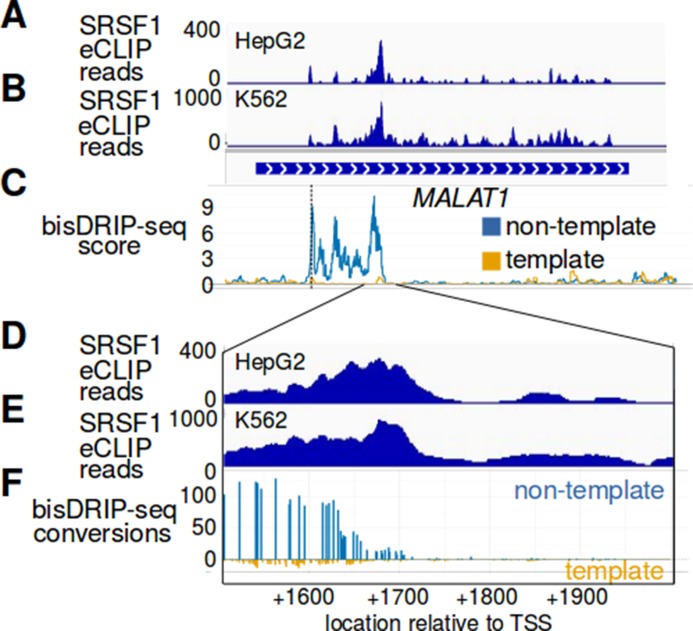
The R-loop in MALAT1 ends at an SRSF1 binding site.(A–F) SRSF1 preferentially binds MALAT1 RNA near the location corresponding to the end of the MALAT1 R-loop. SRSF1 is a splicing factor that was previously shown to suppress R-loop formation (Li and Manley, 2005). SRSF1 eCLIP reads were mapped to the MALAT1 genome locus from the (A) HepG2 ENCFF327NVE ENCODE dataset and from the (B) K562 ENCFF137IAG ENCODE dataset. The cell type is indicated at the top left of each plot. Below the SRSF1 eCLIP reads is a gene model of the MALAT1 genomic locus. (C) The mean bisDRIP-seq scores for the non-template strand (blue) and template strand (orange) of control-treated samples (n = 13) were mapped to the same MALAT1 genomic locus. In (D–F), the region near the end of the MALAT1 R-loop is expanded. (D,E) SRSF1 eCLIP reads were mapped to this expanded region using the same HepG2 ENCFF327NVE ENCODE dataset and K562 ENCFF137IAG ENCODE dataset. In (F), we mapped the end of the R-loop at near-nucleotide resolution. Here the number of bisDRIP-seq conversions on the template strand and non-template strand were plotted below the x-axis (orange) or above the x-axis (blue), respectively. Shown are the total number of conversions observed in all bisDRIP-seq samples (n = 13). In these plots, it is clear that the location of the SRSF1 binding site is adjacent to the end of the MALAT1 R-loop. It is intriguing to speculate that SRSF1 might be involved in defining the 3' boundary of the R-loop in MALAT1.